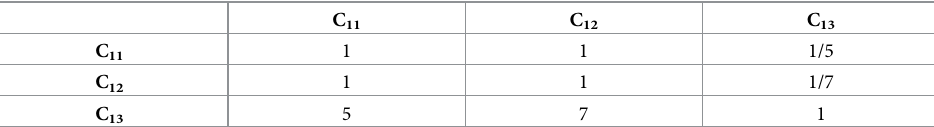
Table 5. Pair-wise comparisons of individual factors.